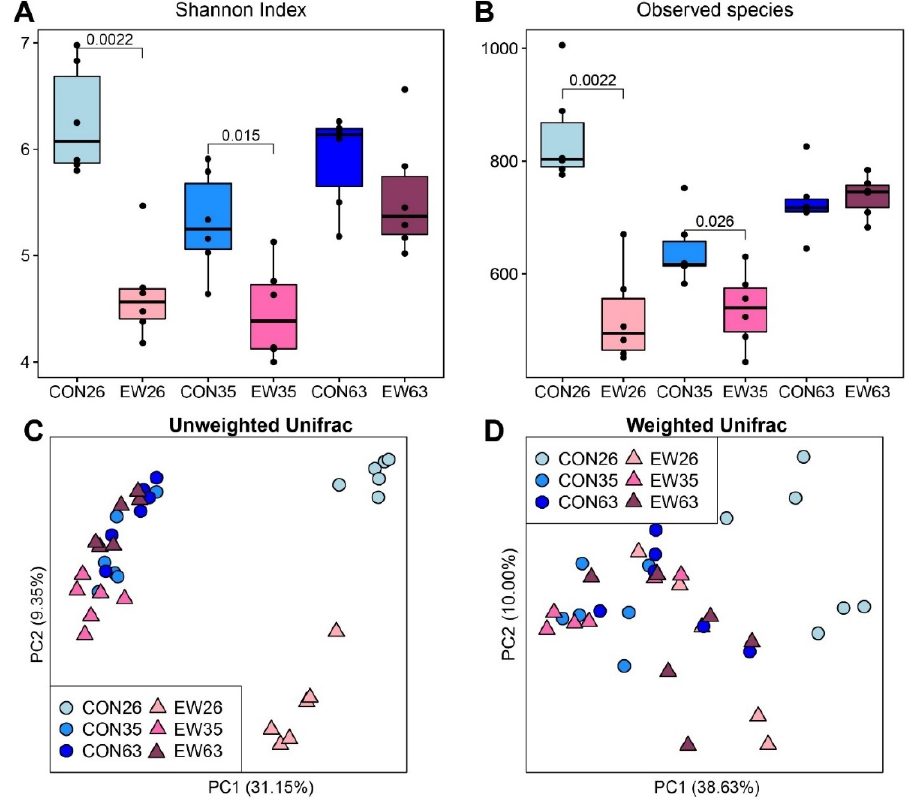
Figure 1. Alpha diversity and similarity of rumen microbiota in control (CON) and early weaned (EW) lambs at 26, 35, and 63 days of age (d). ( A , B ): Alpha diversity in the rumen microbial community based on the Shannon index and observed species; ( C , D ): The principal coordinate analysis (PCoA) based on the unweighted and weighted Unifrac distances. Each point represents a unique sample. CON26 = control at 26 d; EW = early weaning group at 26 d, the rest can be deduced by analogy. Principal Coordinate Analysis (PCoA) was performed based on unweighted and weighted Unifrac distances (Figure 1C,D). The rumen microbiota of lambs in the EW